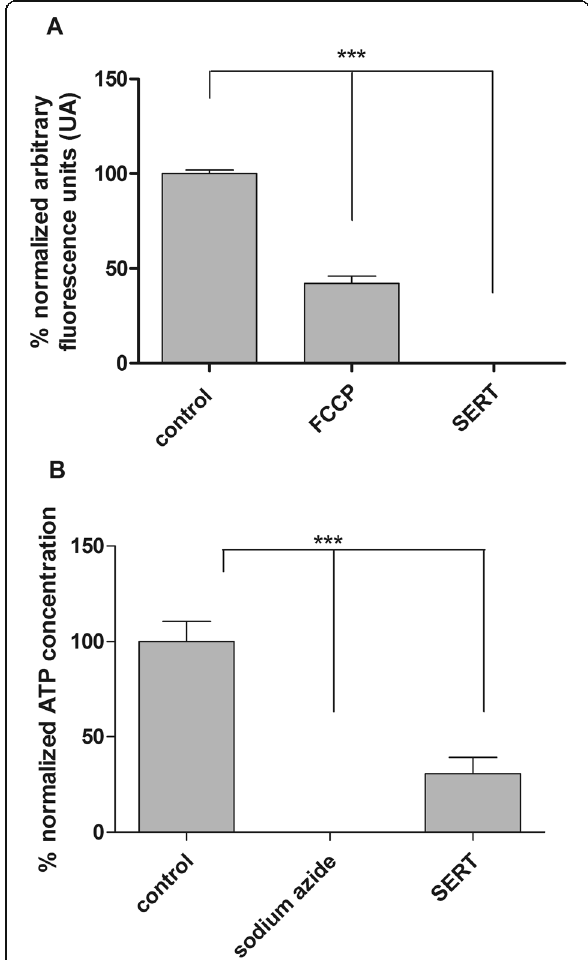
Fig. 1 Evaluation of the bioenergetic parameters of T. cruzi . a Mitochondrial membrane potential of T. cruzi trypomastigotes treated with sertraline for 1 h at 2 μ M, positive control (FCCP) and negative control (untreated cells). The fluorescence was determined using a fluorimetric microplate reader (FilterMax F5 Multi-Mode Microplate Reader) at 540 and 595 nm for excitation and emission, respectively. *** ( p <0.05); b Evaluation of the ATP levels of T. cruzi incubated for 1 h with sertraline at 2 μ M. The levels were measured in a spectroluminometer plate reader (FilterMax F5 Multi-Mode Microplate Reader) using the ATP determination Kit (Life technologies). *** p